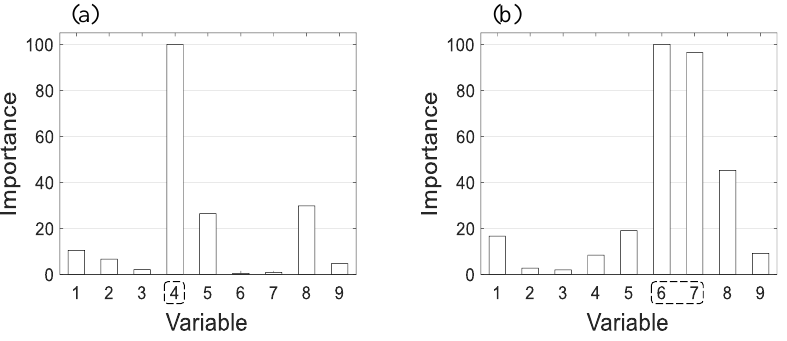
Figure 10. (Artificial fault cases) Variable importance values obtained by Method 1: ( a ) Case 1; ( b ) Case 2.